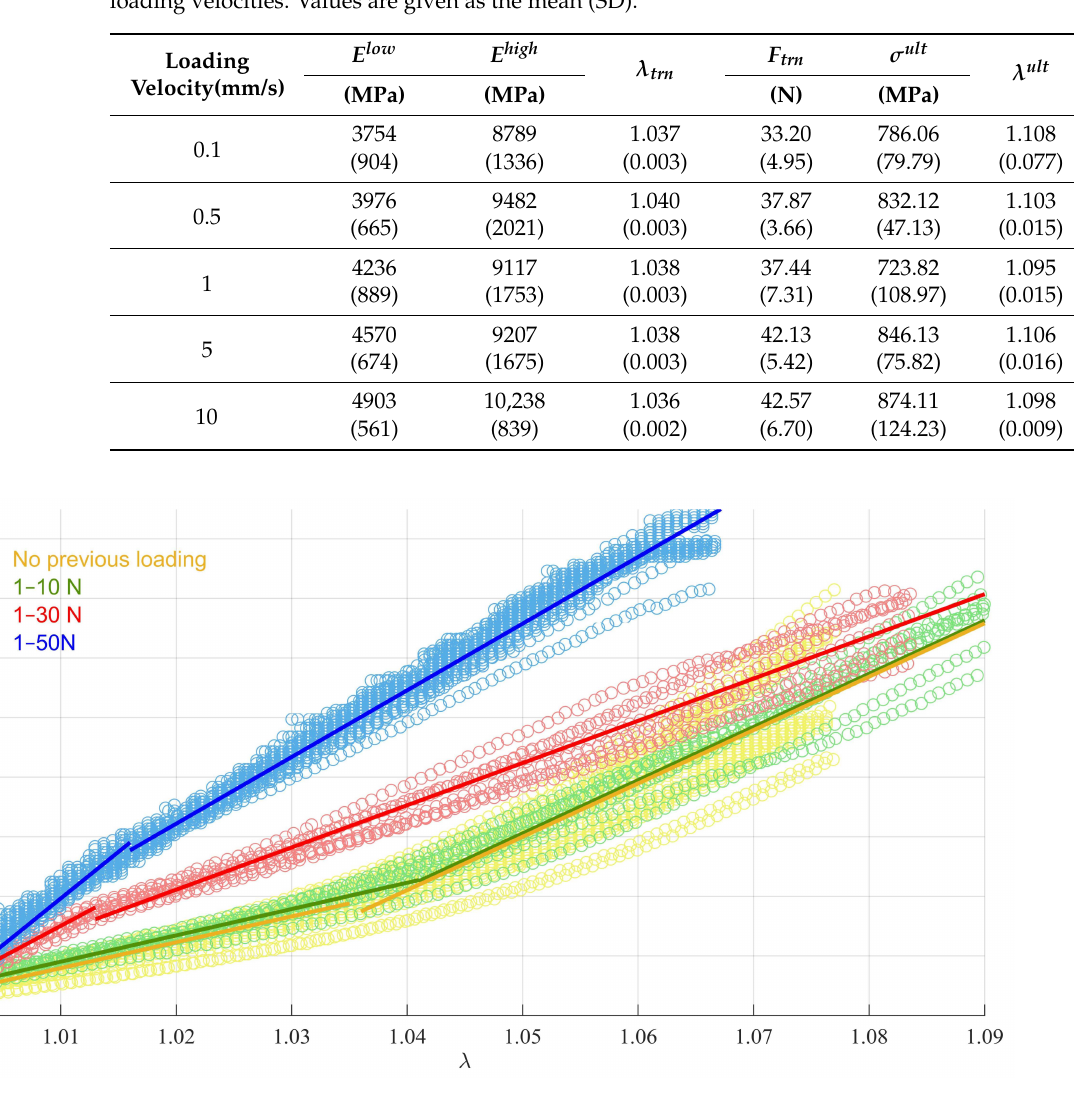
Figure 3. Results of the load-to-failure tests without and immediately after different cyclic loading ranges. Markers indicate the experimental data. Continuous lines are the fitted bilinear